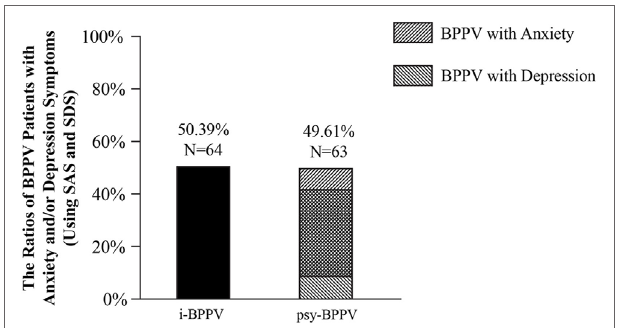
FigUre 1 | The ratios of anxiety and/or depression symptoms in BPPV patients.